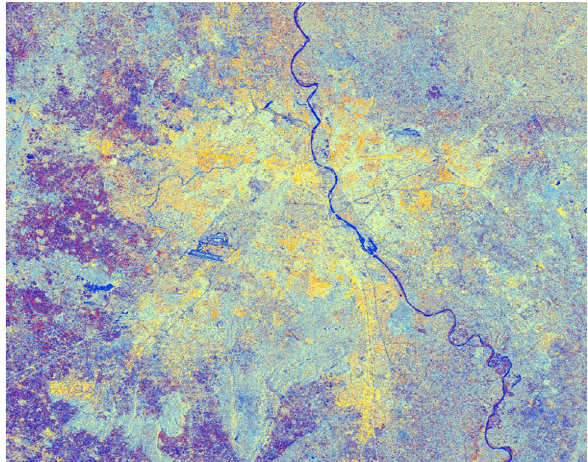
Figure 13. Colour composite image (Red: VV, Green: VH, Blue: VH/VV) of the Sentinel-1 dual-polarization C-band data with application of the speckle/spatial filters.